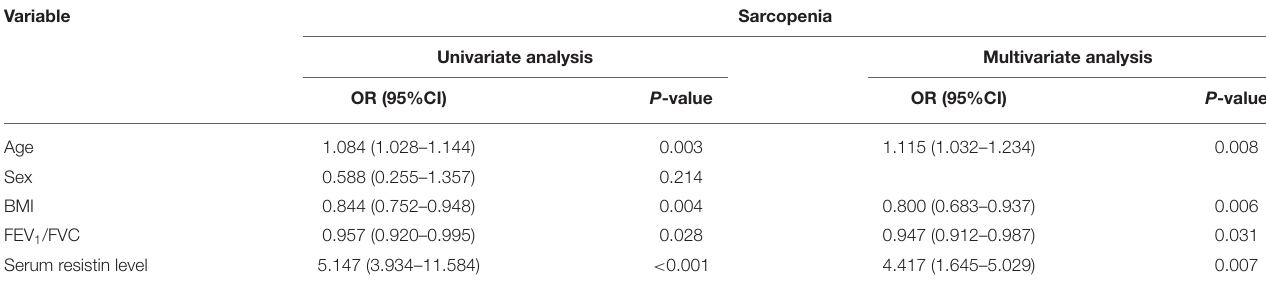
TABLE 2 | Clinical factors associated with sarcopenia in patients with